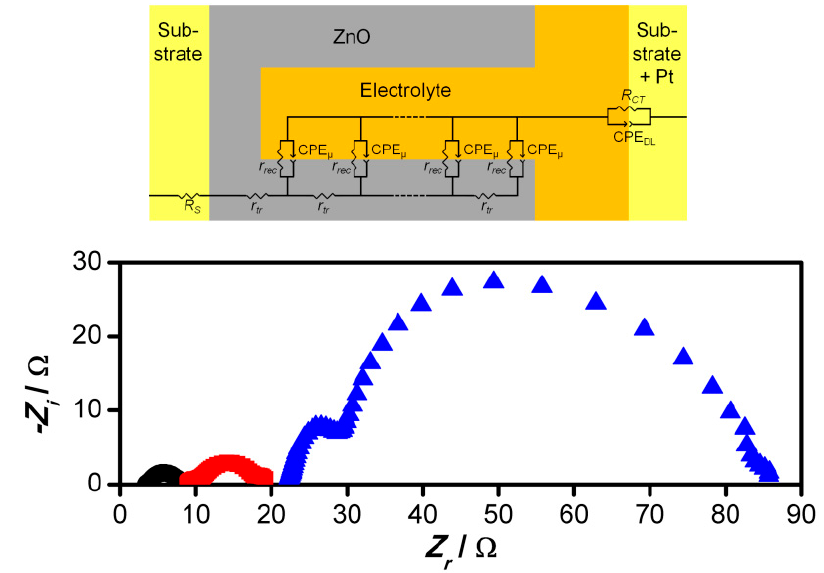
Figure 9. Applied electrochemical impedance spectroscopy (EIS) model for fitting ( top ) and exemplary EIS spectra recorded at V = 300 mV ( bottom ). ( ■ ) Flexible DSSC module “1”. ( ● ) Flexible DSSC module “2”. ( ♦ ) Flexible small-scaled DSSC. R S : Series resistance. r tr : Transport resistance. r rec : Recombination resistance. CPE µ : Constant phase element describing the chemical capacitance. R CT : Charge-transfer resistance. CPE DL : Constant phase element describing the double-layer